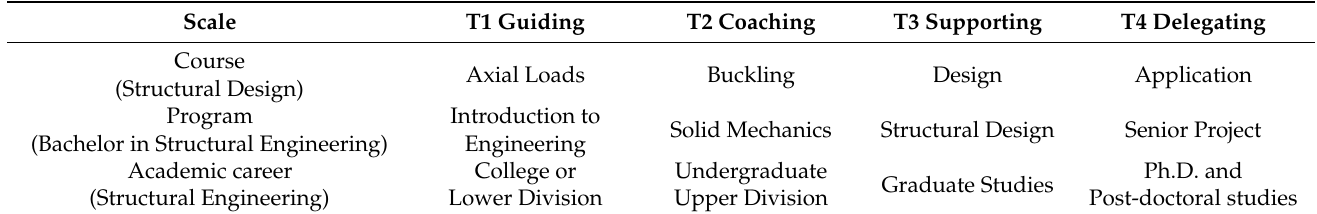
Table 3. Sample scaling of situational teaching at the course, program, and academic career levels.